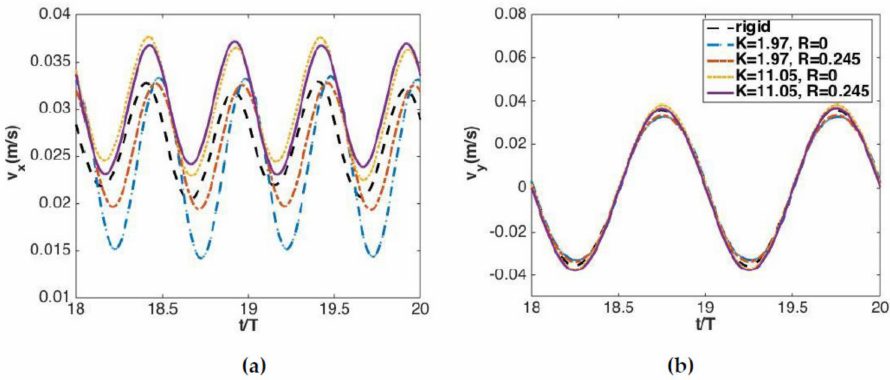
Figure 6. Instantaneous velocities in a semi-local coordinate, pointing to ( a ) travelling direction and ( b ) perpendicular direction.